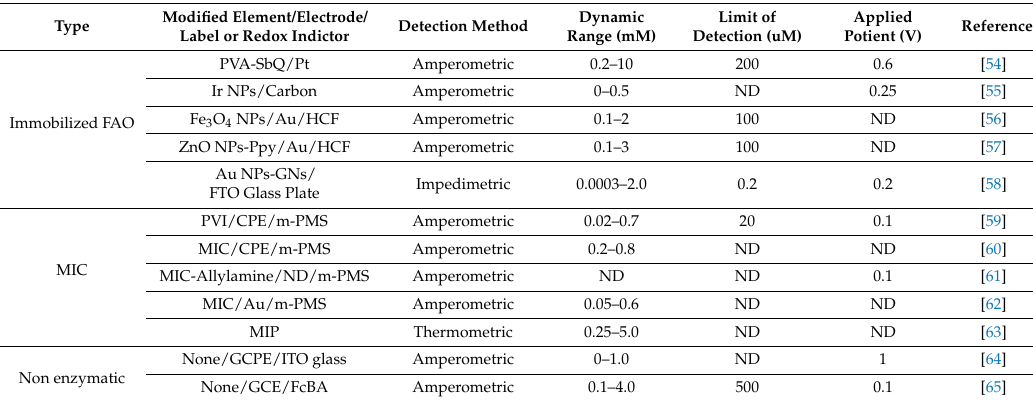
Table 4. Comparison of FV sensors based on different oxidation